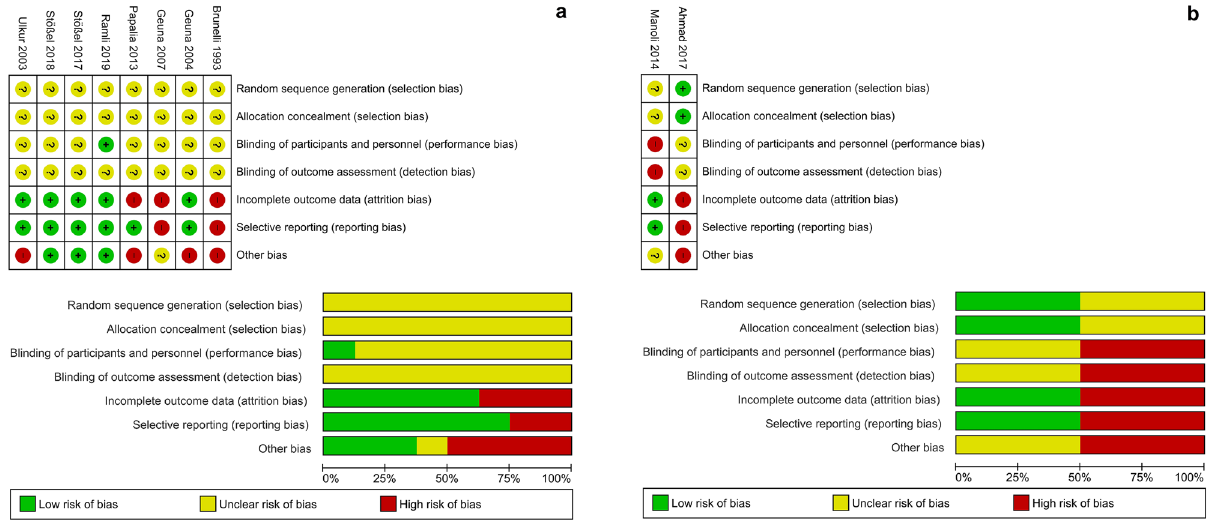
Figure 2. Assessed risk of bias of all preclinical ( a ) and clinical ( b ) studies included in the meta-analysis. As recommended by the PRISMA guidelines, the authors performed an analysis of bias, which could result in over- or underestimation of the effect of interventions, in all included studies. Depicted are the scored risk of bias for individual items (upper part) and the percentage of the assessed bias risk (bottom part) across all preclinical ( a ) and clinical ( b ) studies included in the